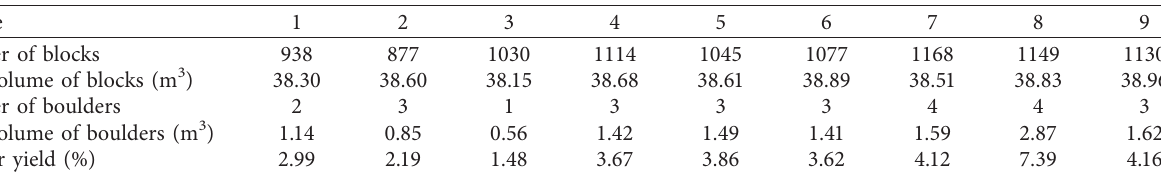
Figure 2: (a)–(i) Velocity distribution diagram in x -direction at 0.05s of blasting under 9 schemes (units in (a)–(i) are all m/s). (j) Maximum velocity- x statistics. (a) Scheme 1. (b) Scheme 2. (c) Scheme 3. (d) Scheme 4. (e) Scheme 5. (f) Scheme 6. (g) Scheme 7. (h) Scheme 8. (i) Scheme 9. (j) Maximum velocity- x Table 5: Bench rock crushing situation.